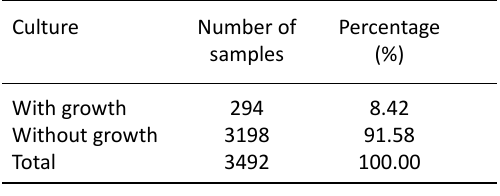
table 1. Distribution of samples with and without growth Culture